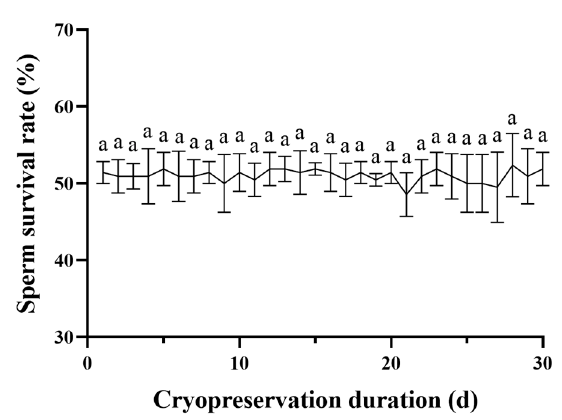
Figure 6. Survival rates of P. trituderculatus sperm after different freezing times. There were no significant differences between the survival rate of 1–30 d cryopreservation sperm. The same letter means that the difference is not significant ( p > 0.05) ( n = 60).